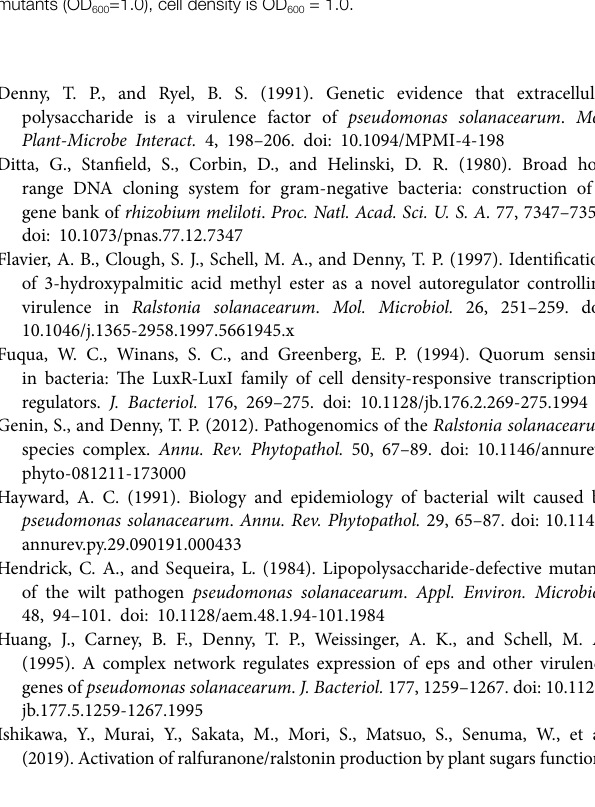
Supplementary Table S4 | Ct data of phcA and phcR gene in EP1 and mutants (OD 600 =1.0), cell density is OD 600 =